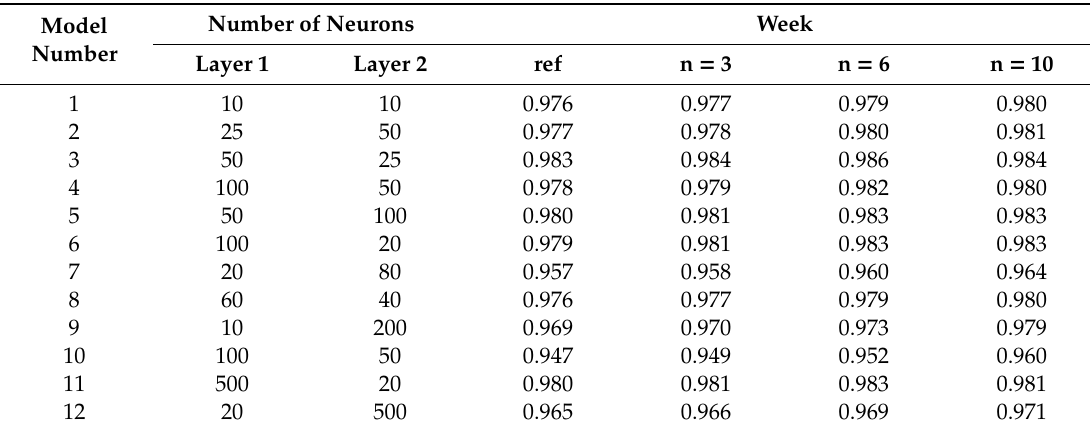
Table 7. Correlation analysis for the reference signals and wavelet-based filtration